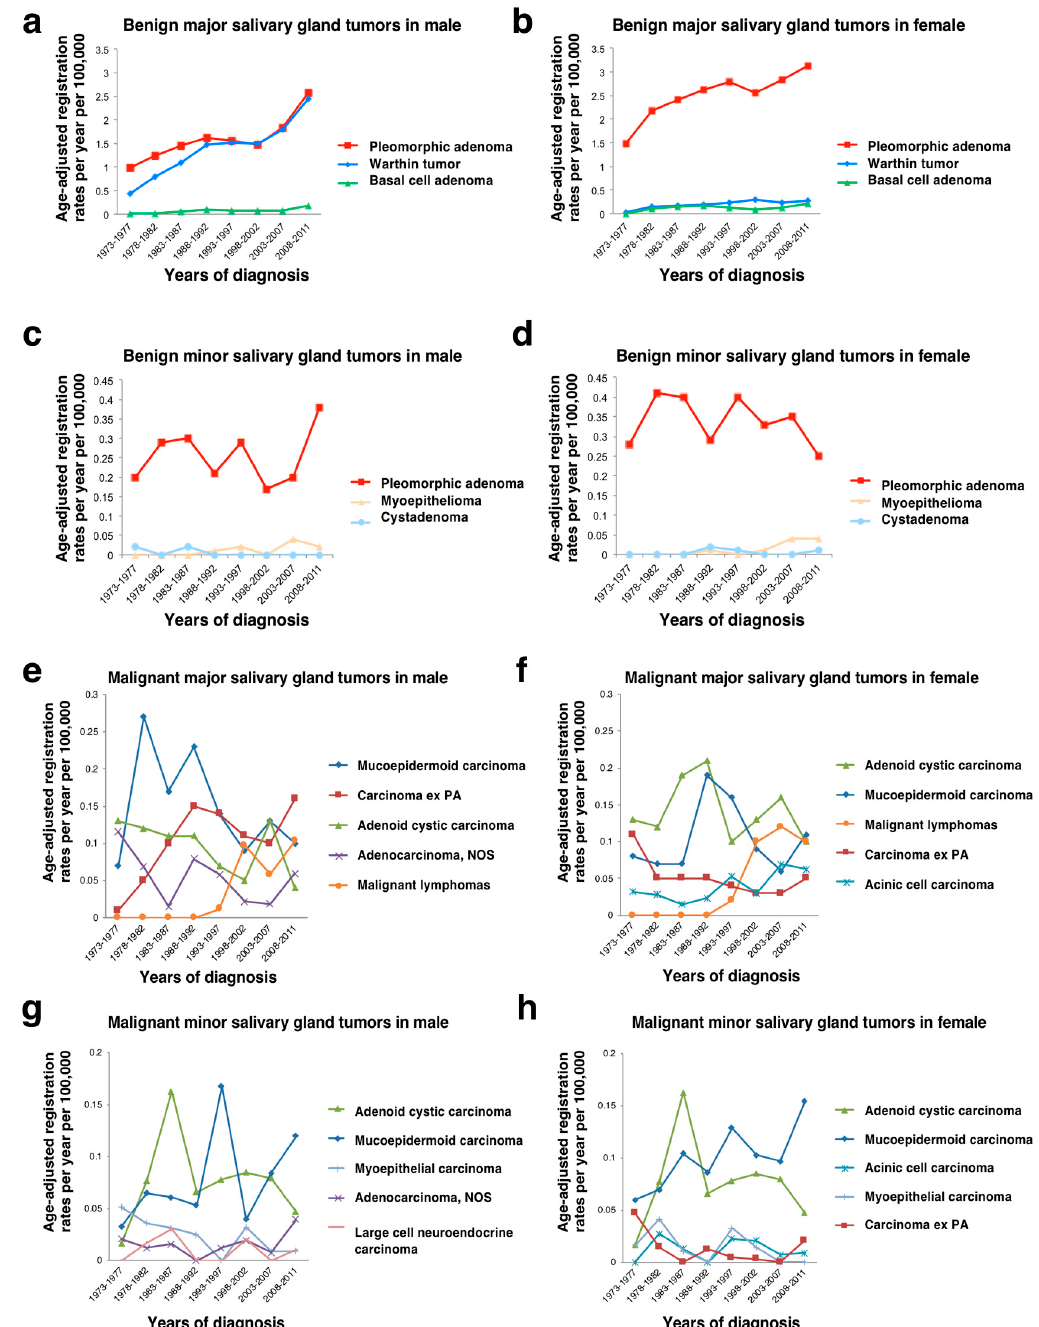
Figure 6. Age-adjusted registration rates per year per 100,000 population in major and minor salivary gland tumors. ( a – d ) benign salivary gland tumors, ( e – h ) malignant salivary gland tumors; NOS: not otherwise specified; PA: pleomorphic adenoma.